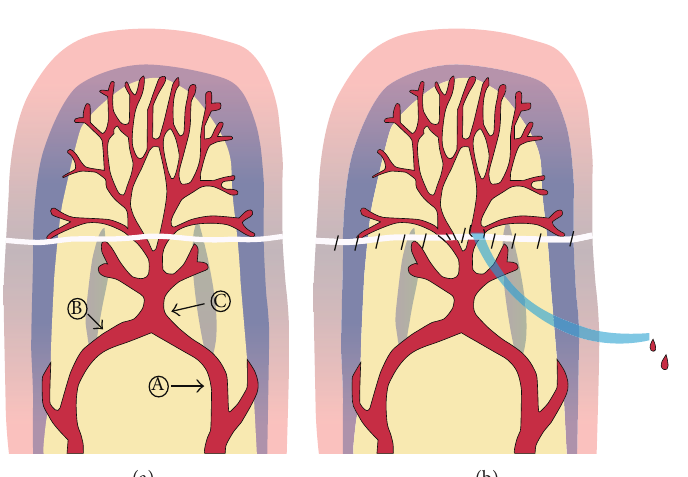
Figure 1: Details of the mechanical leech. (a) Schematic of the mechanical leech. A: Proper digital artery, B: distal transverse arch, and C: central artery. (b) After the arterial anastomosis, the remaining branch of the central artery, which drains after the artery inflow, was easily identified. The angioneedle was anastomosed to the branch and functioned as a conduit for venous